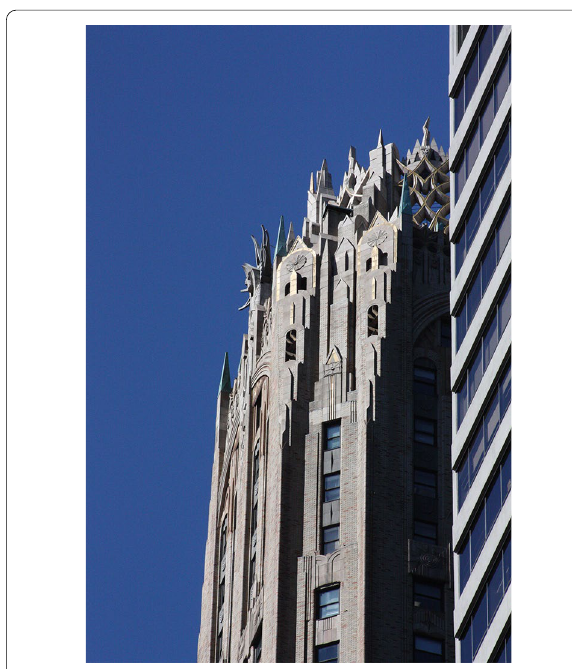
Fig. 15 The General Electric Tower in New York represents electricity and radio waves